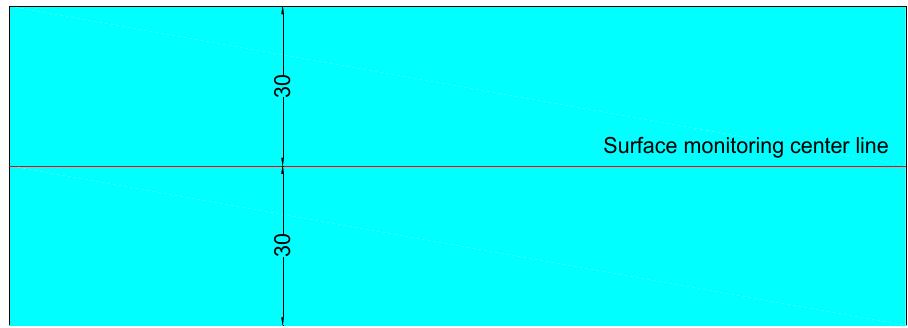
Figure 12. Location of the center line of the surface surveying.